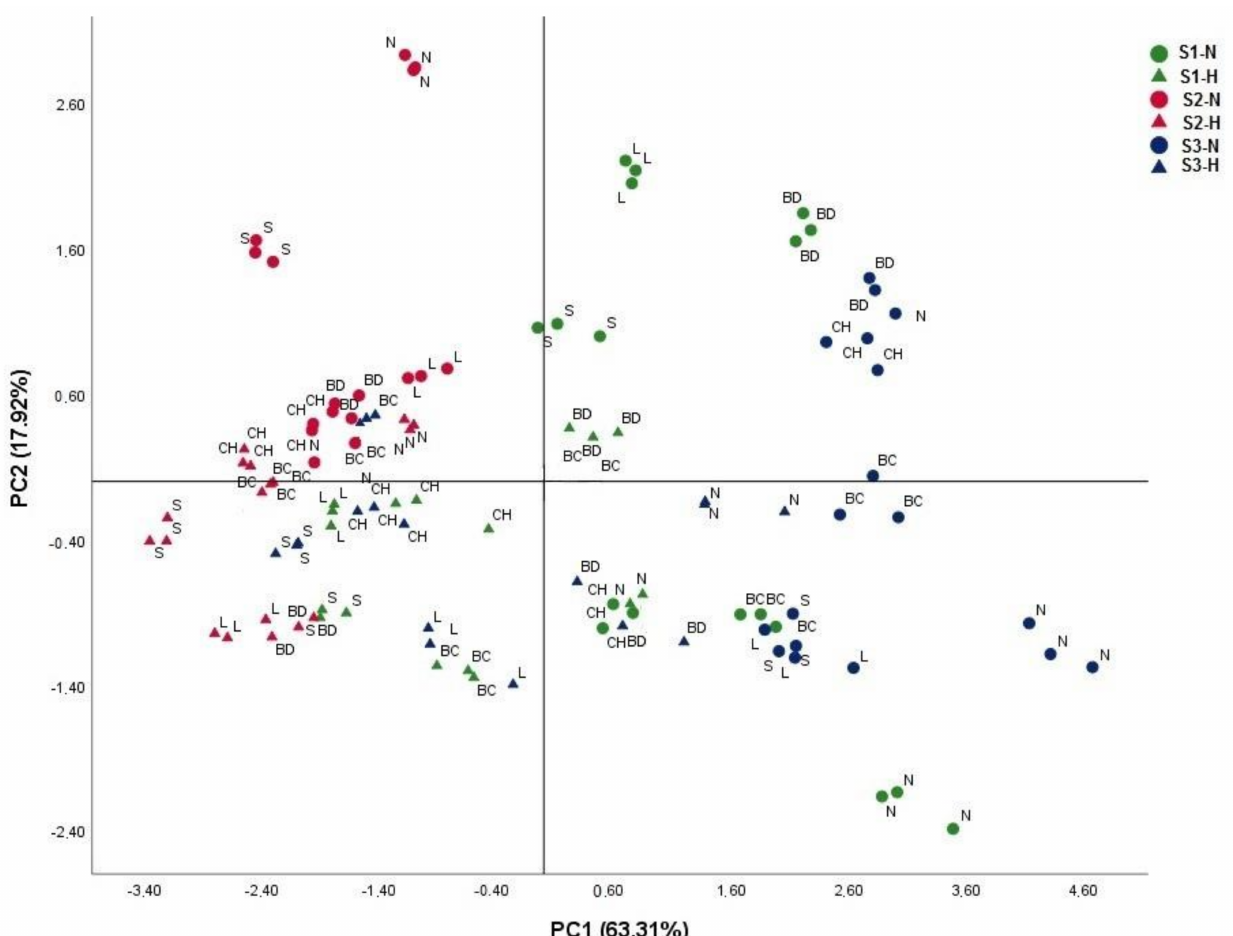
Figure 2. Principal component analysis (PCA) performed on six genotypes of Vicia faba under either normoxia or hypoxia defined by root dry weight, shoot dry weight, root length, shoot length, nodules number and chlorophyll content. The percentage of variation is presented on each